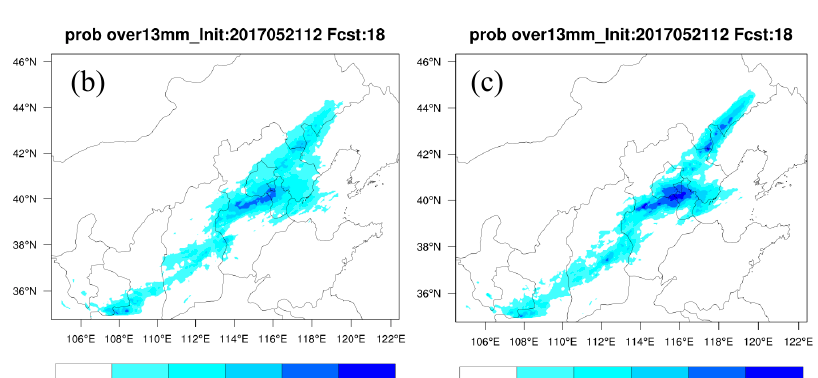
Figure 9 . Observational state and heavy precipitation probability of the 6 h accumulative precipitation: (a) observation (units: mm); (b) precipitation probability of being greater than 13 mm (units: %) for the Down ensemble forecast; and (c) as in (b) but for the Breeding forecast.